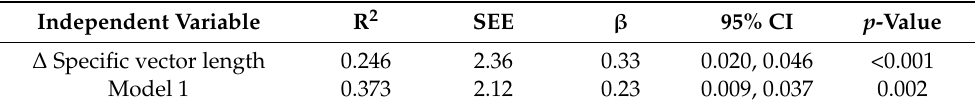
Table 2. Linear regression analysis for independent variables and changes ( ∆ ) in the percentage of fat mass considering all the participants as a whole group.